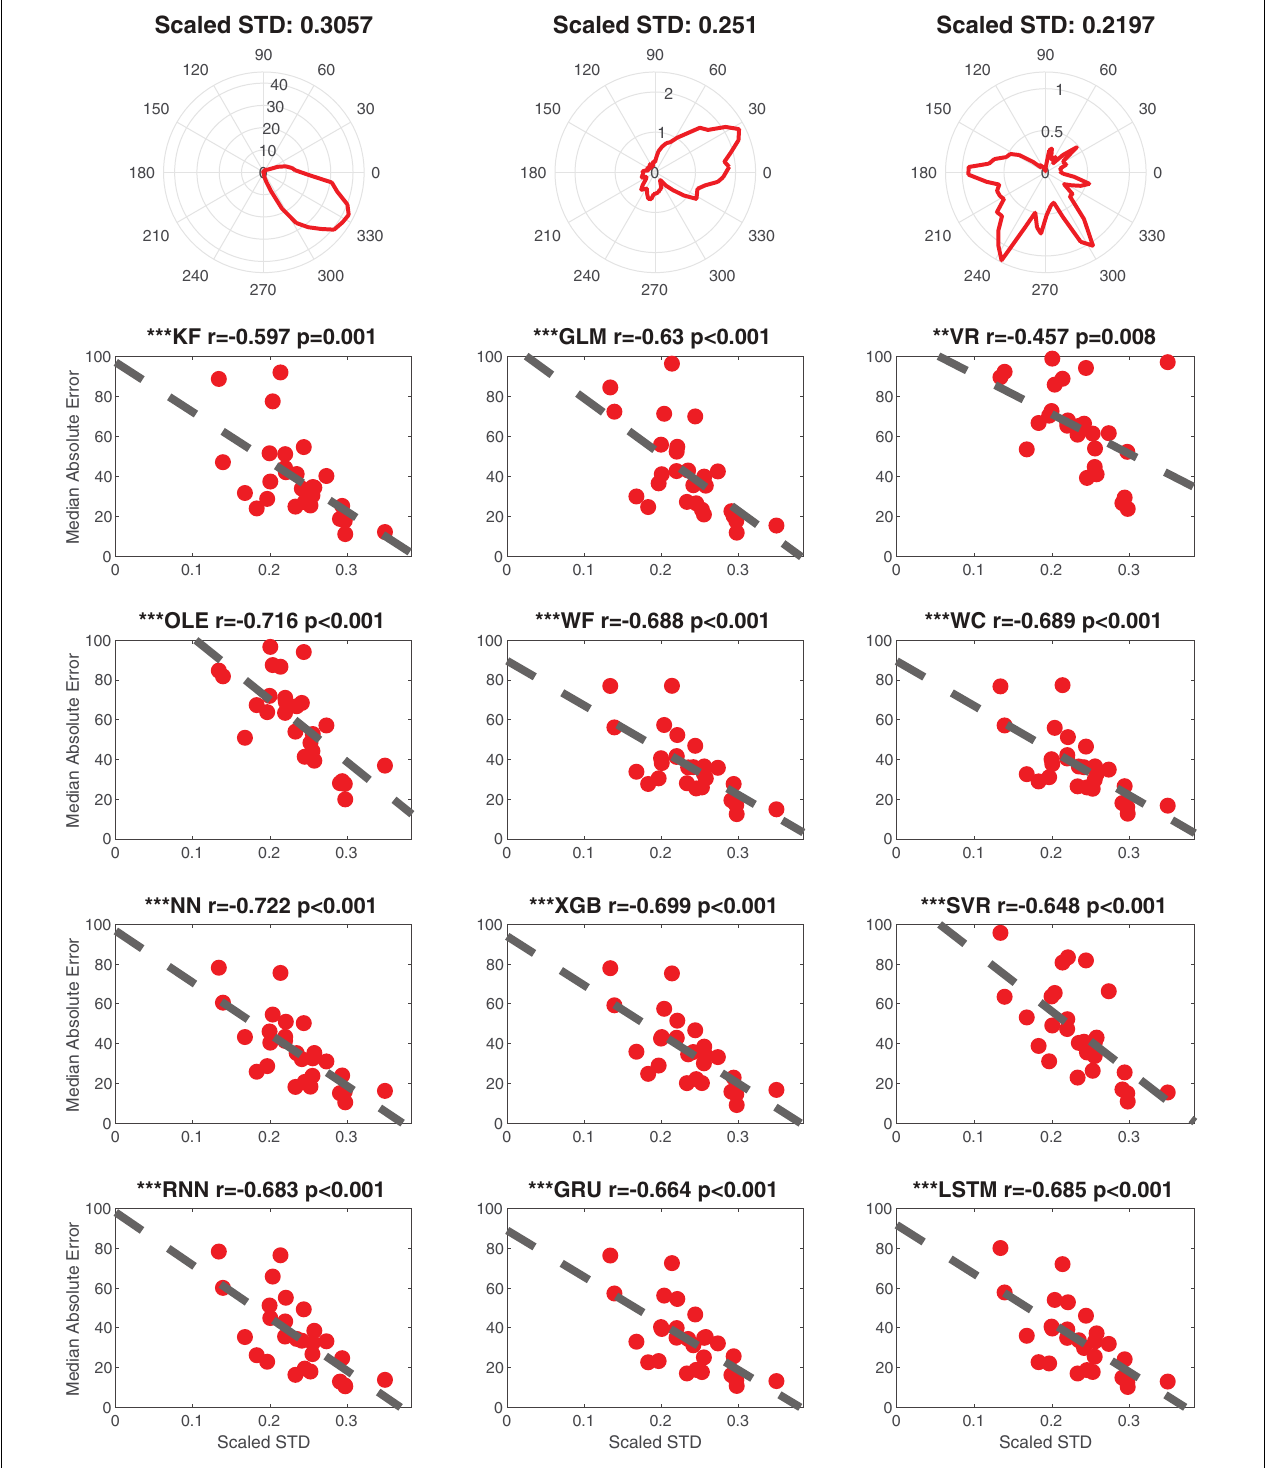
FIGURE 11 | Tuning influences decoding accuracy. Top Row. Examples illustrating the relationship between scaled standard deviation (scaled STD) and tuning for single cells from ATN (left) , PoS (middle), and MEC (right) . The plots of tuning curves were smoothed by a Gaussian kernel function. The scaled STD is computed by taking standard deviation of the scaled (divided by maximum) firing rate. Bottom 4 Rows. Linear regression data is shown for each decoding method as a function of scaled STD (i.e., indicator of tuning strength). One cell was randomly selected from each dataset to avoid repeatedly sampling the same decoding score. ∗∗∗ p < 0.001; ∗∗ p <